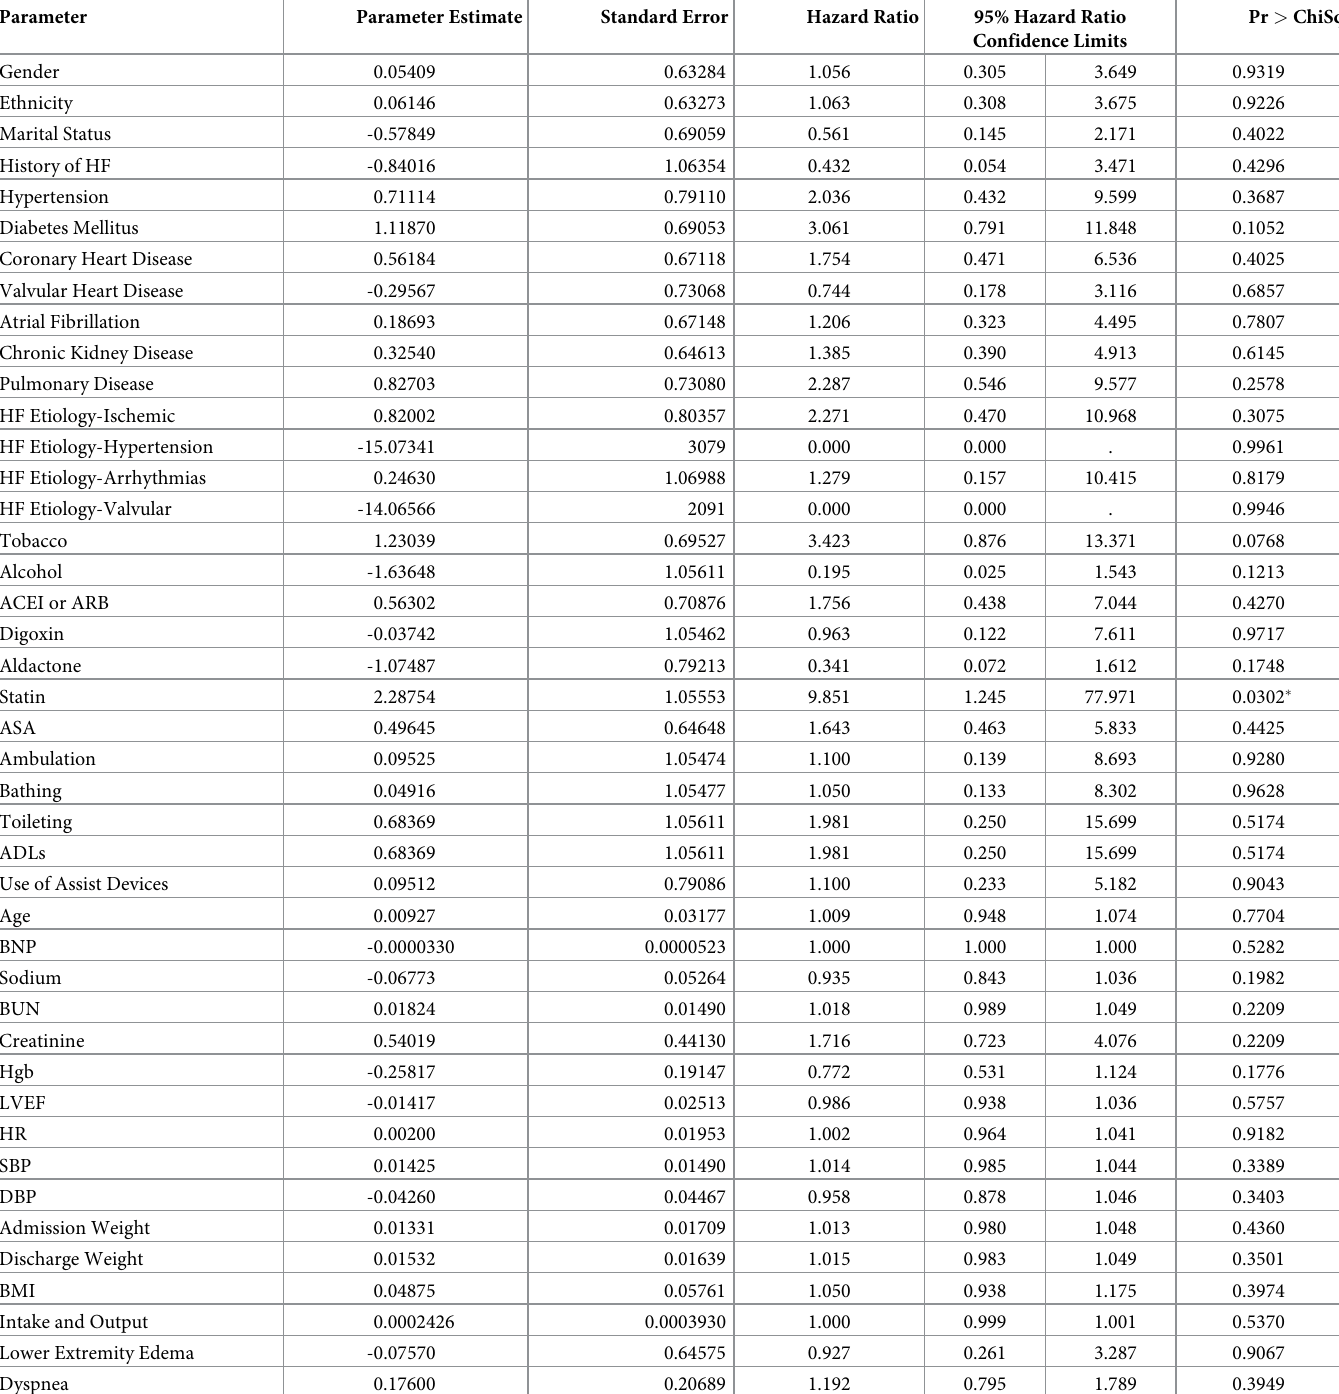
Table 2. Univariate analysis using Cox model to identify baseline risk